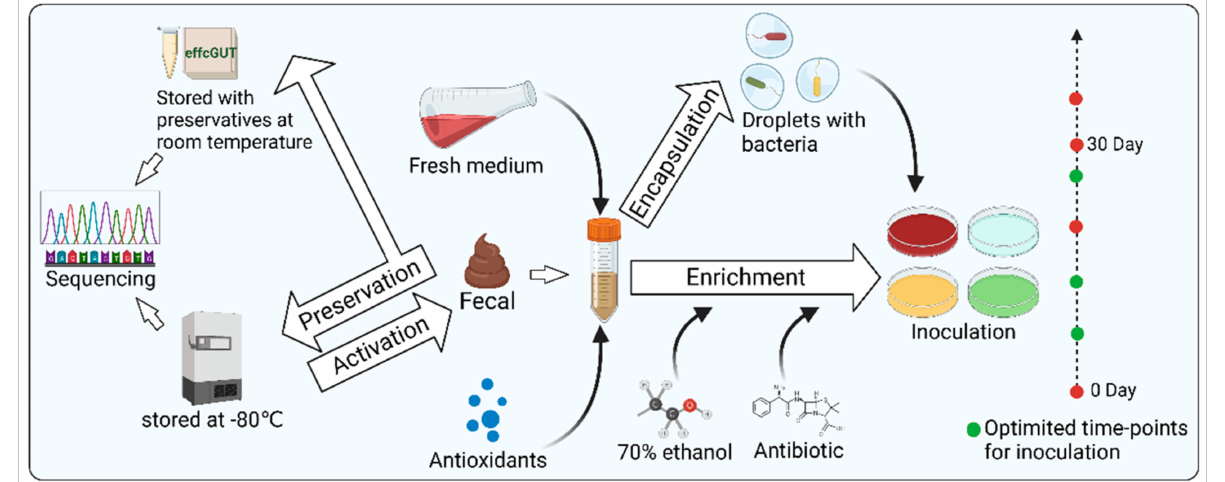
Figure 3. Schematic diagram of sample processing including microbial enrichment, anaerobic protec- tion, and sample preservation. Created with